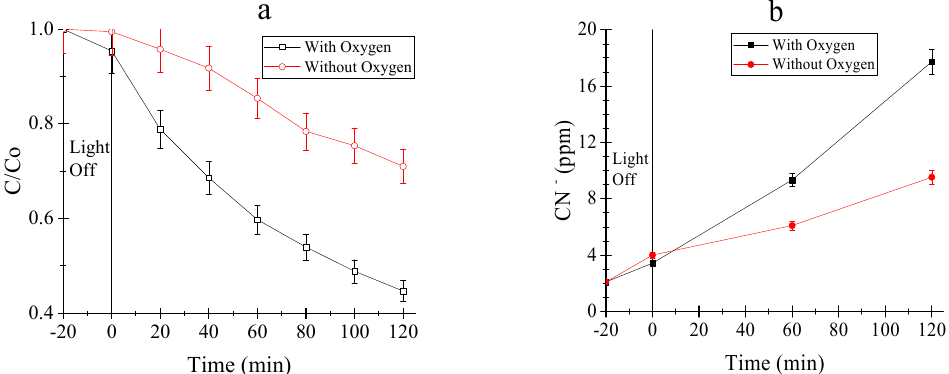
Figure 5. ( a ) Cyanocomplex (hexacyanoferrate III) degradation; and ( b ) release of free cyanide. Operating conditions: Initial concentration of K 3 [Fe(CN) 6 ] of 100 ppm, catalyst load of 0.5 g/L, 20 min of adsorption, Power supply: 20 W, air or nitrogen flow of 0.5 L/min, reaction time of 2 h.